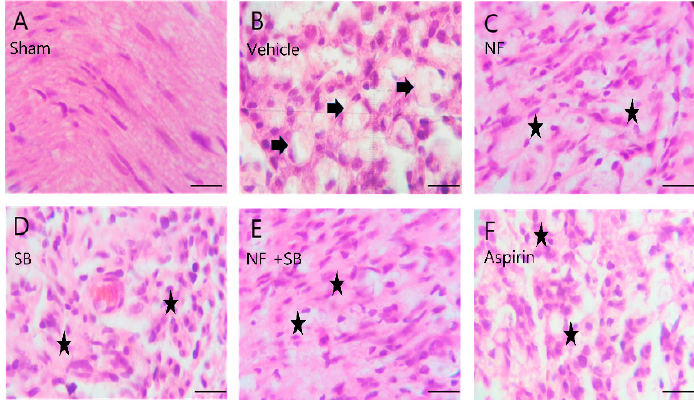
Figure 5. Representative H&E staining of sciatic nerves on 7th day after surgery. ( A ) Sham group shows well-organized sciatic nerve fibers and no structure defect shows well-organized nerve fiber tissue. ( B ) Vehicle group shows several areas of edema and degraded myelin sheath with vacuolation (arrows). ( C ) NF group, ( D ) SB group, ( E ) NF + SB group, ( F ) aspirin group, ( C – F ) The nerve fiber density was increased, and the vacuolar-like degeneration was decreased at the 7th day (asterisks). Scale bars = 10 µm.